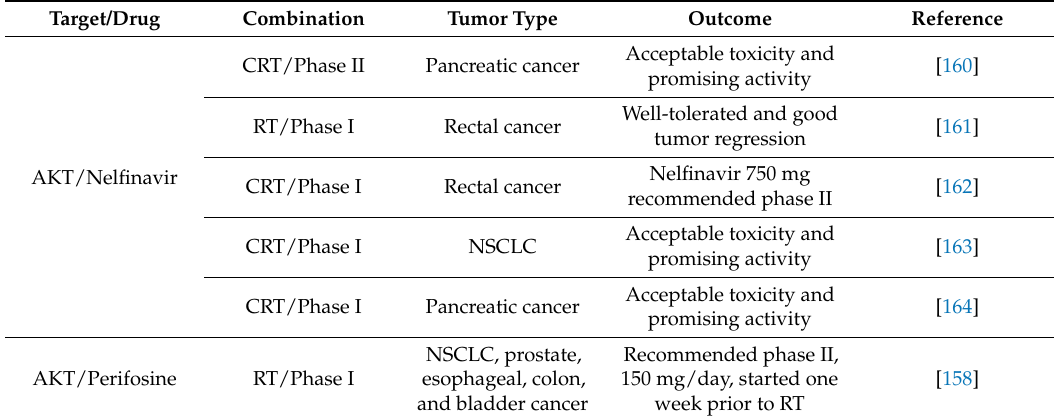
Table 2. Clinical trials of the AKT antagonists in combination with radiotherapy or